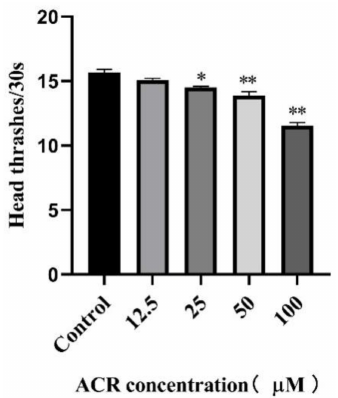
Figure 3. Effect of ACR exposure (12.5, 25, 50, and 100 µ M for 48 h) on head thrash frequency of C. elegans . Values are means ± SD. * Compared with the control group, p < 0.05; ** compared with the control group, p <